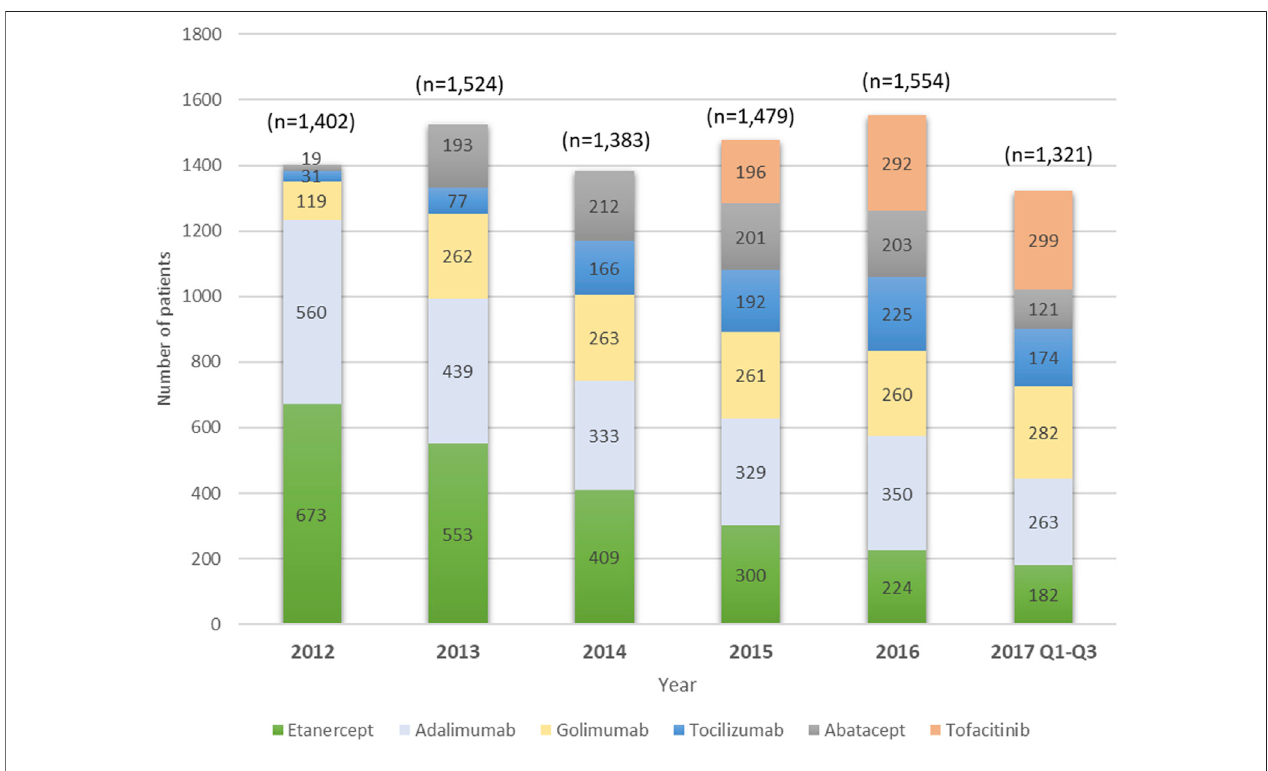
FIGURE 2 | Trend of index treatment, 2012 –